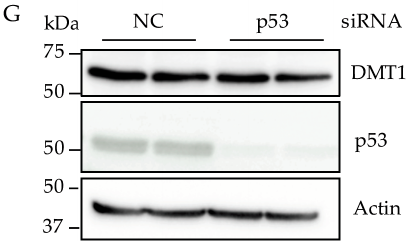
Figure 1. Knockdown of p53 increases endogenous ZIP14 (Zinc-regulated transporter and Iron- regulated transporter-like Protein 14) levels in human hepatoma HepG2 cells. ( A ) cells were treated with negative control (NC) siRNA or p53-targeting siRNA #1 for 48 h. Cell lysates were analyzed by immunoblotting for ZIP14 by using an anti-FLAG antibody. Blot images were visualized by Odyssey Infrared System (Licor) for quantification; ( B – C ) quantification of ZIP14 and p53 protein levels shown in panel A; ( D ) cells were treated with two different p53-targeting siRNAs (#1 and #2) for 48 h. Cell lysates were analyzed by immunoblotting for ZIP14. After stripping, blots were re-probed for p53 and β -actin; ( E ) ZIP14 transcript levels after p53 knockdown were quantified and normalized to those of β -actin. Experiments were repeated at least three times with consistent results; ( F ) cells were incubated with three different DMT1-targeting siRNA for 48 h. Cell lysates were analyzed by immunoblotting for DMT1. After stripping, blots were re-probed for β -actin; ( G ) cells were treated with p53-targeting siRNA #1 for 48 h. Cell lysates were analyzed by immunoblotting for DMT1. After stripping, blots were re-probed for p53 and β -actin. NC: universal scrambled negative control siRNA, * p < 0.05, ** p < 0.001, *** p < 0.0001, compared with control.